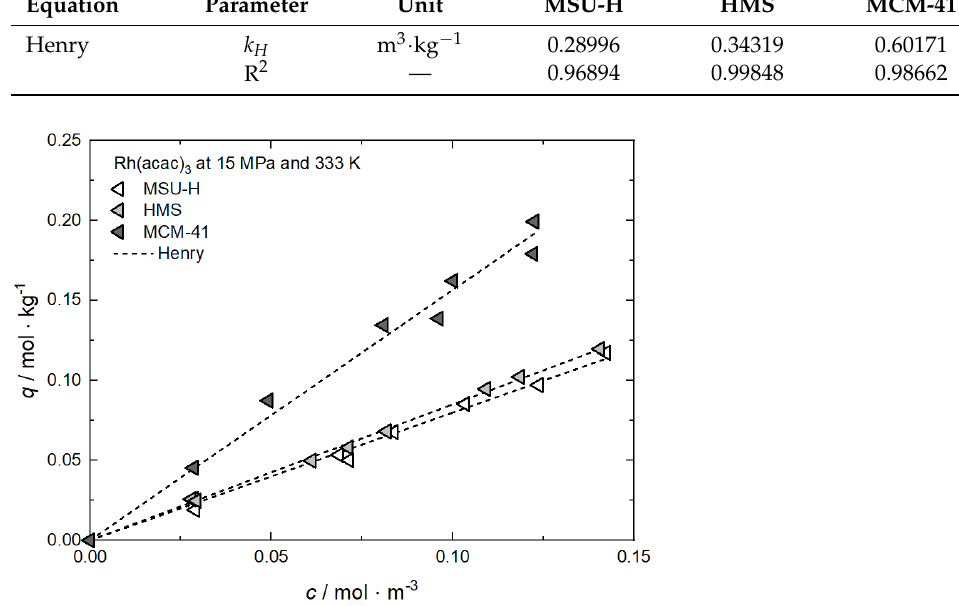
Figure A10. Uptake of Rh(acac) 3 at 15 MPa and 313 K on different substrates; experimental data taken from [62]. Table A10. Adsorption isotherm parameters for Rh(acac) 3 from scCO 2 solution at 15 MPa and 313 K on different substrates [62].